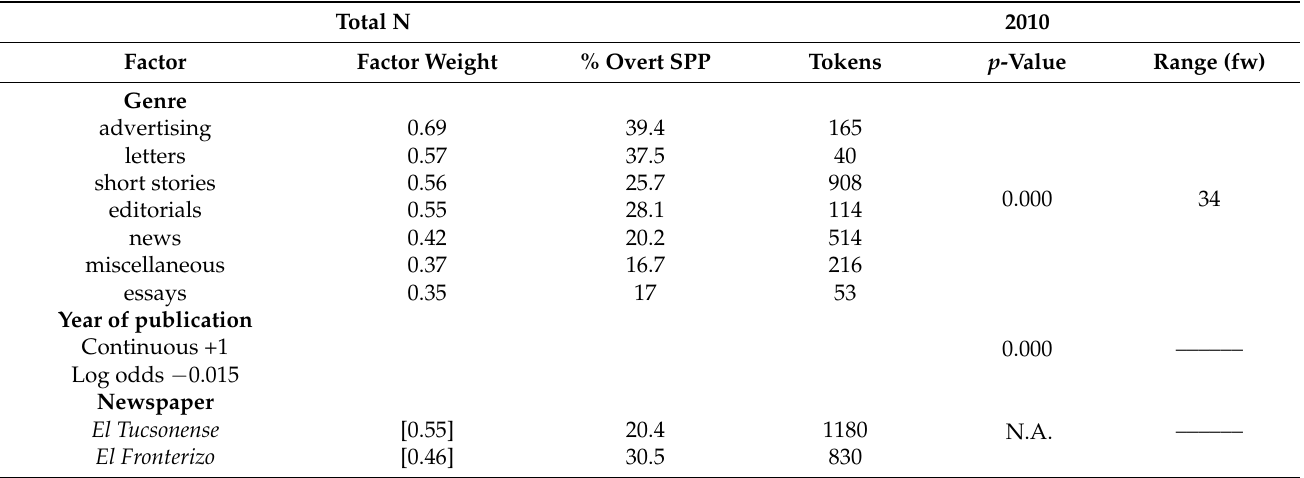
Table 7. Rbrul analysis of external factors contributing to overt SPPs in Tucson 19th and 20th century